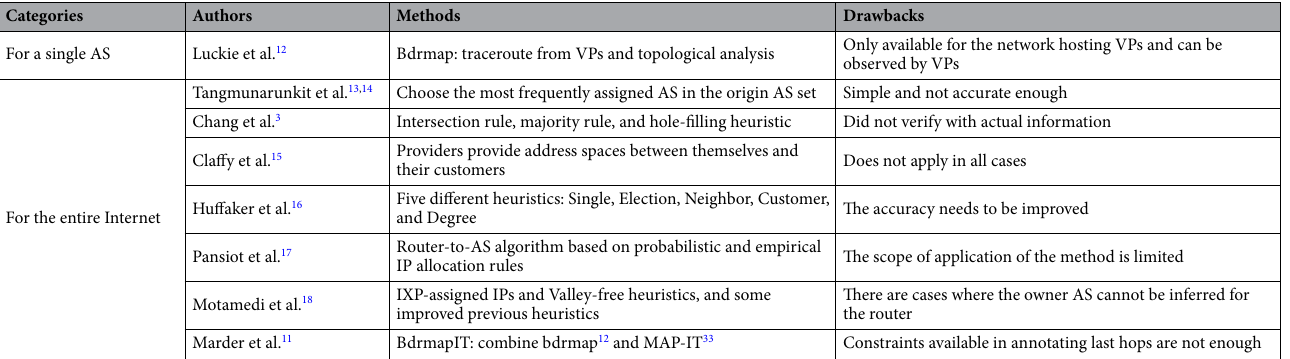
Table 1. Related works of router ownership